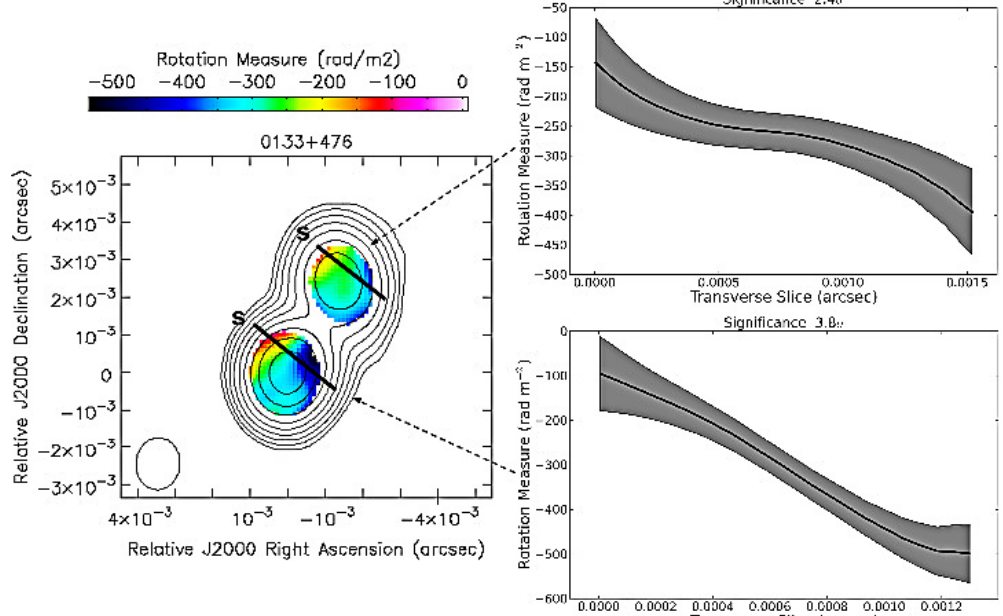
Figure 1. Transverse rotation measure (RM, in units of rad/m 2 ) gradient across the VLBA core region and jet of the Active Galactic Nuclei (AGN) 0133 + 476, based on the 8.1–15.3 GHz data of [4], reanalyzed in [9]. Intensity contours with the RM distribution superposed in colour are shown. The beam size is shown in the lower left-hand corner of the map. The panels to the right show RM slices for the regions indicated in the map, with the slices starting with the letters “S” on the left-hand panel. The significances of the two slices are 3.0 σ (core region) and 2.4 σ